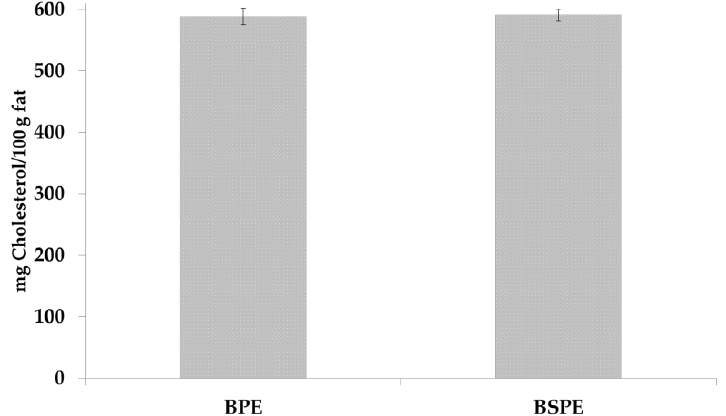
Figure 5. Cholesterol content in biscuits formulated with pasteurized (BPE) and spray-dried (BSPE) egg products .